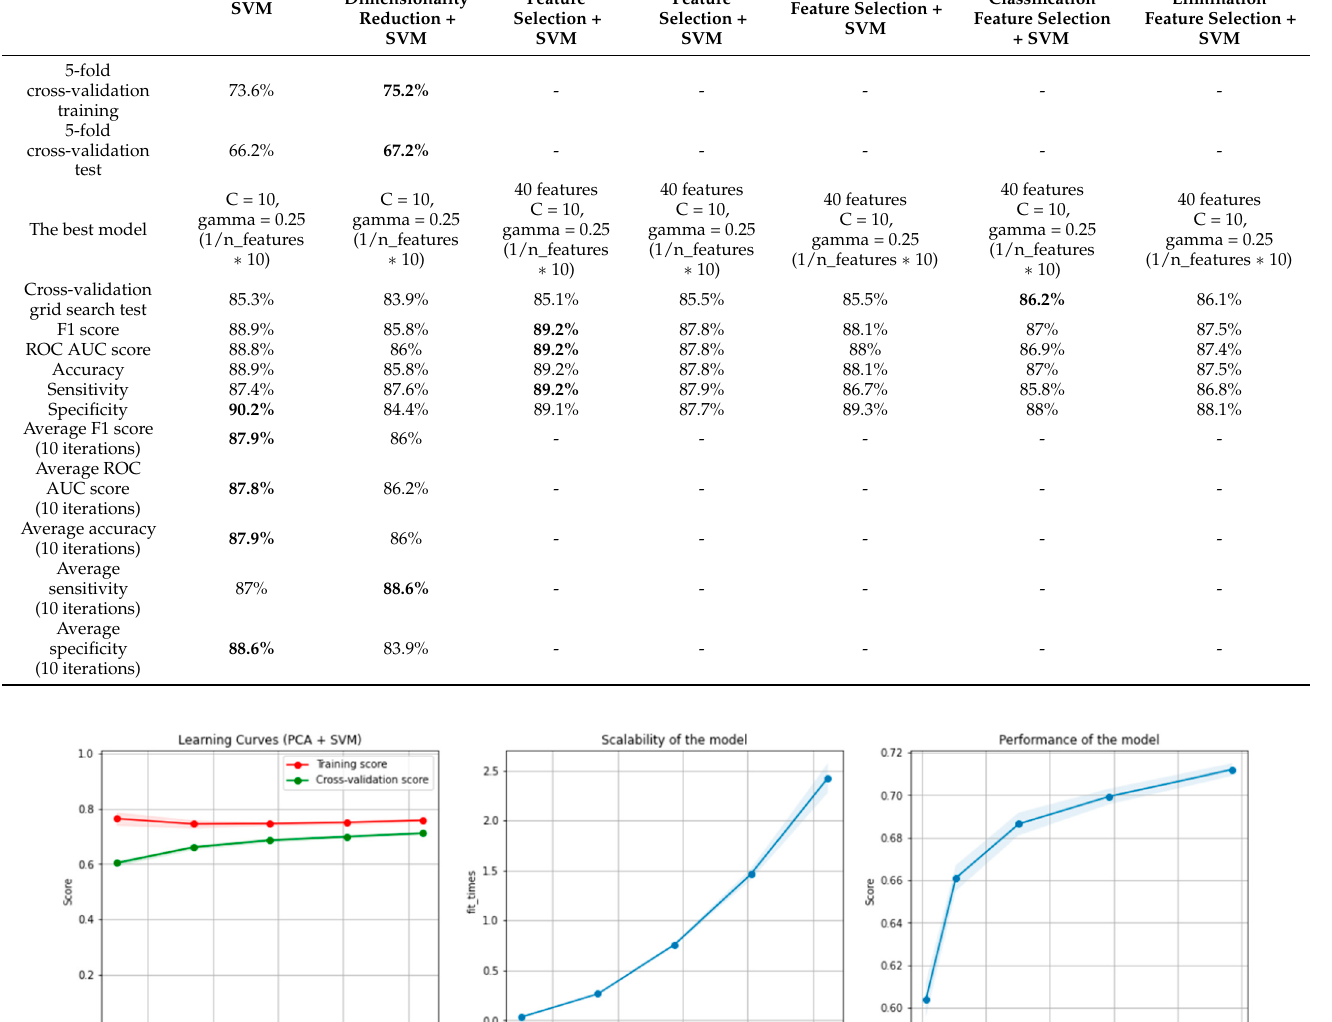
Figure 13. Learning curves, scalability and model performance for the PCA + SVM algorithm, for the overlapping dataset. Table 6 presents the results of the DT algorithms, applied on the overlapping dataset. The highlighted values represent the highest scores obtained. Table 6. Results of the DT algorithms applied on the overlapping dataset.